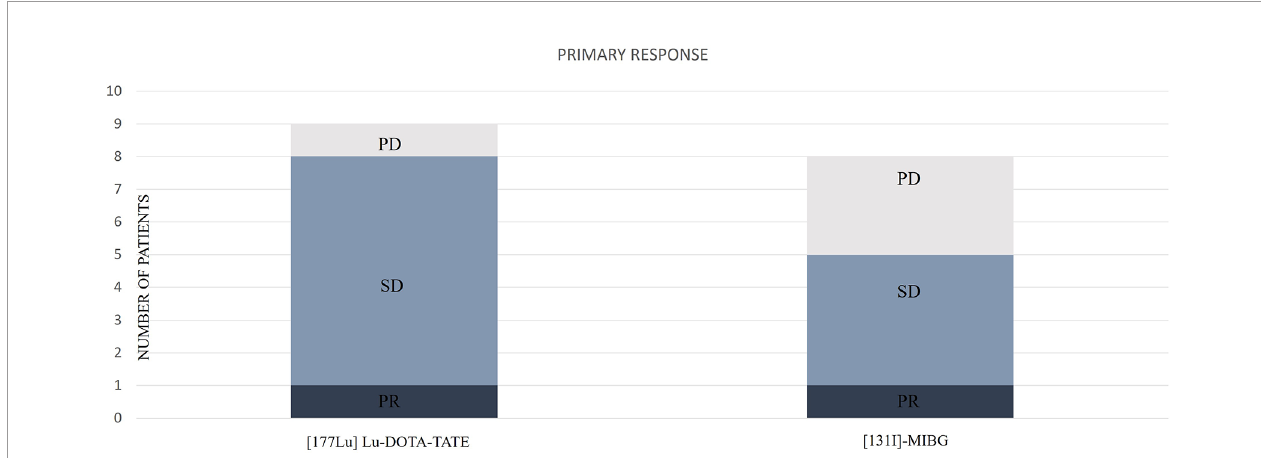
FIGURE 4 | Distribution of the primary responses according to [ 177 Lu]Lu-DOTA-TATE or [ 131 I]MIBG. PD, progressive disease; SD, stable disease; PR, partial response.